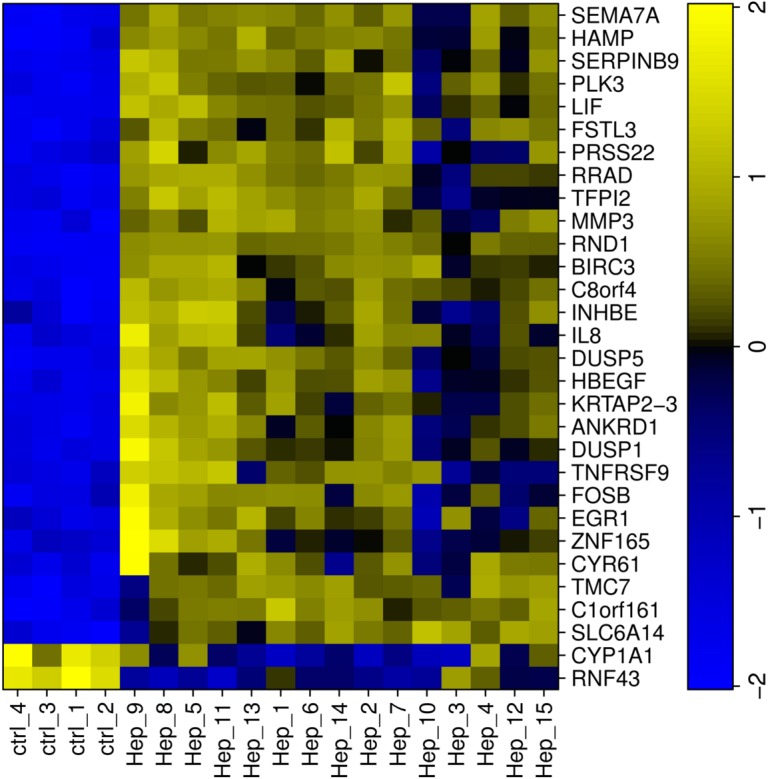
Differentially expressed genes with large variance across HCC samples.HCC cells were stimulated with conditioned media from HSCs from 15 different human donors (Hep_1-Hep_15) while control samples (ctrl1-4) were incubated with plain medium. Of the significant differentially expressed genes upon incubation with conditioned media, only the ones with large variation across HCC samples are shown (for details please see Material and Methods). Expression data was scaled to mean = 0 and standard deviation = 1, such that negative values (blue) indicate lower expression in the sample compared to the mean and positive values (yellow) higher expression in the sample compared to the mean.